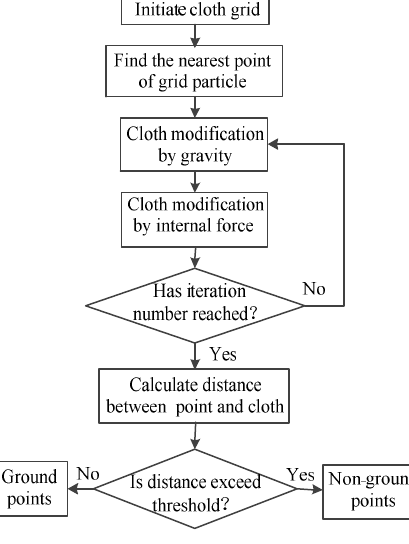
Figure 2.The flowchart of the CSF